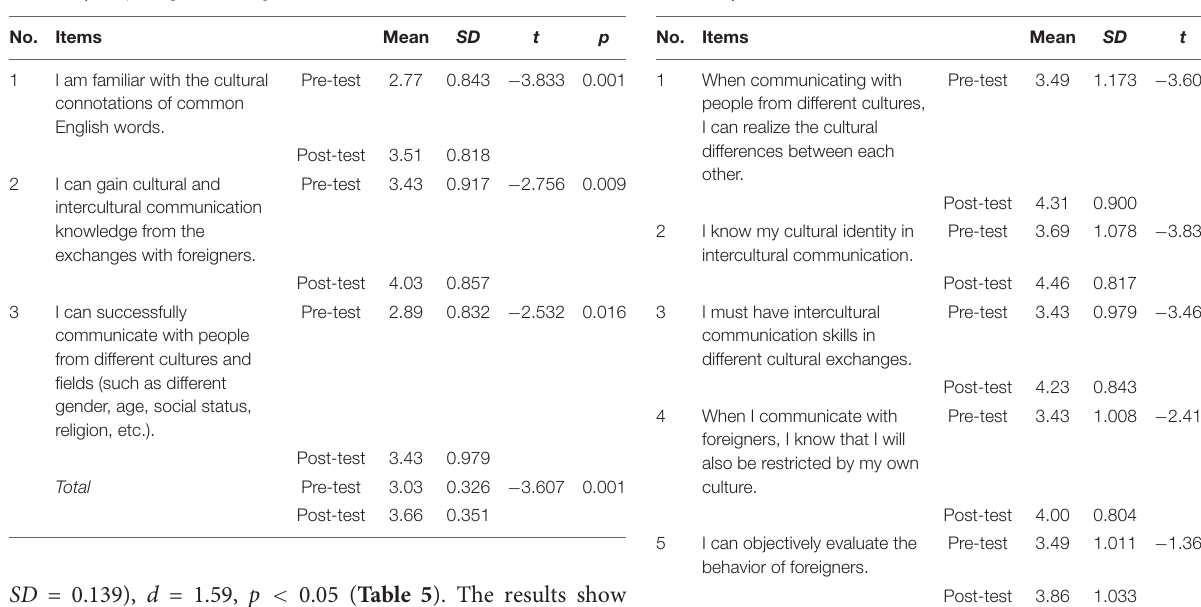
TABLE 4 | Interpreting and relating dimension of ICC. TABLE 5 | Awareness dimension of